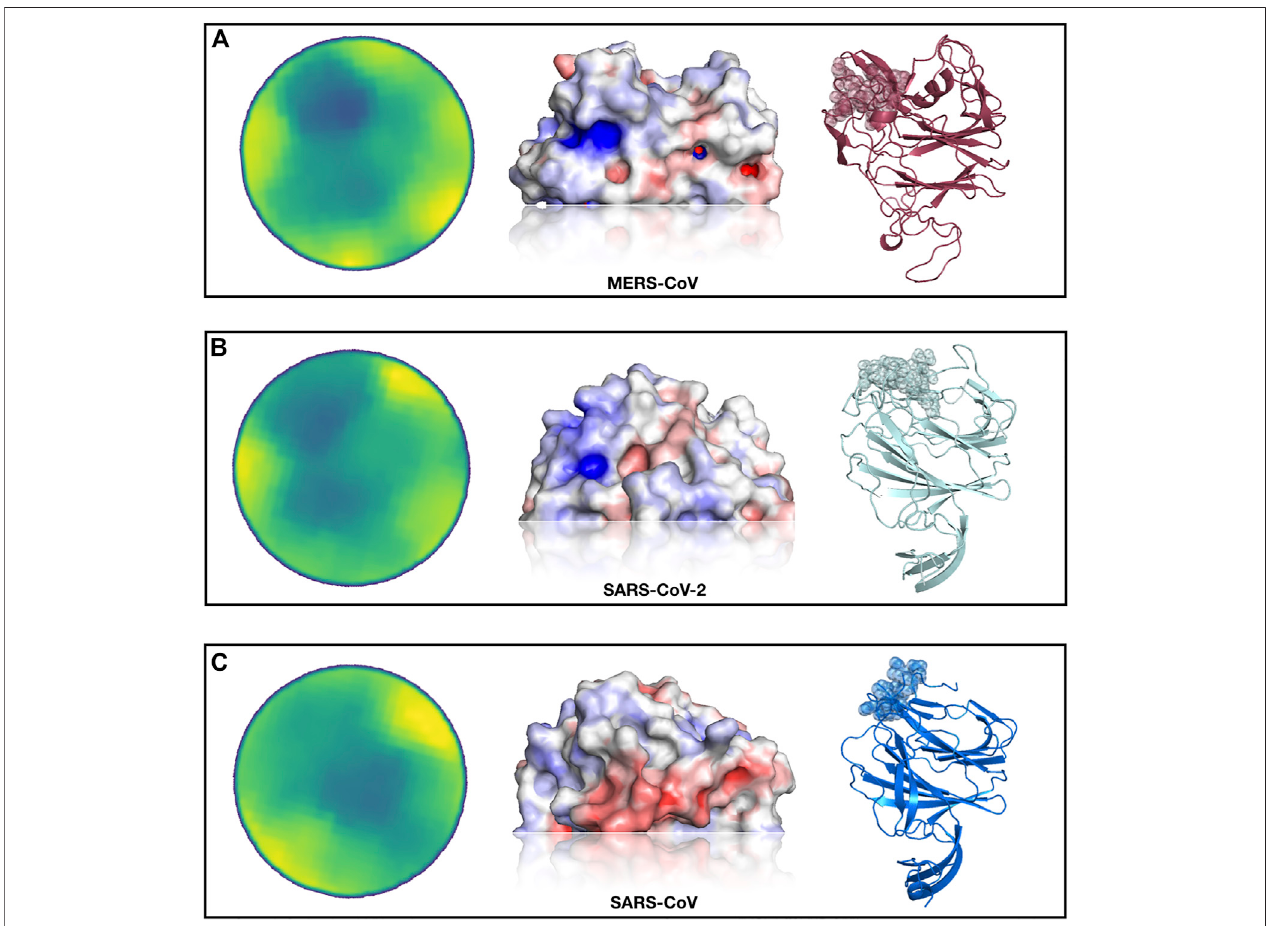
FIGURE3| Identi fi cationofaSARS-CoV-2spikeregionverysimilartothesialic-acidbindingsiteonMERS-CoVspike. (A) Fromlefttoright,projectedregionofthe real sialic-acid binding siteon MERS-CoV, electrostatic potential surface ofthesame region and cartoonrepresentation oftheMERS-CoV spike protein withthebinding site highlighted. (B) Putative sialic-acid binding region on SARS-CoV-2 as predicted by our Zernike-based method. From left to right, the projected region of putative interaction site between SARS-CoV and sialic acid, electrostatic potential surface, and cartoon representation of the SARS-CoV spike protein with the binding site highlighted. (C) Same as (B) but for SARS-CoV spike